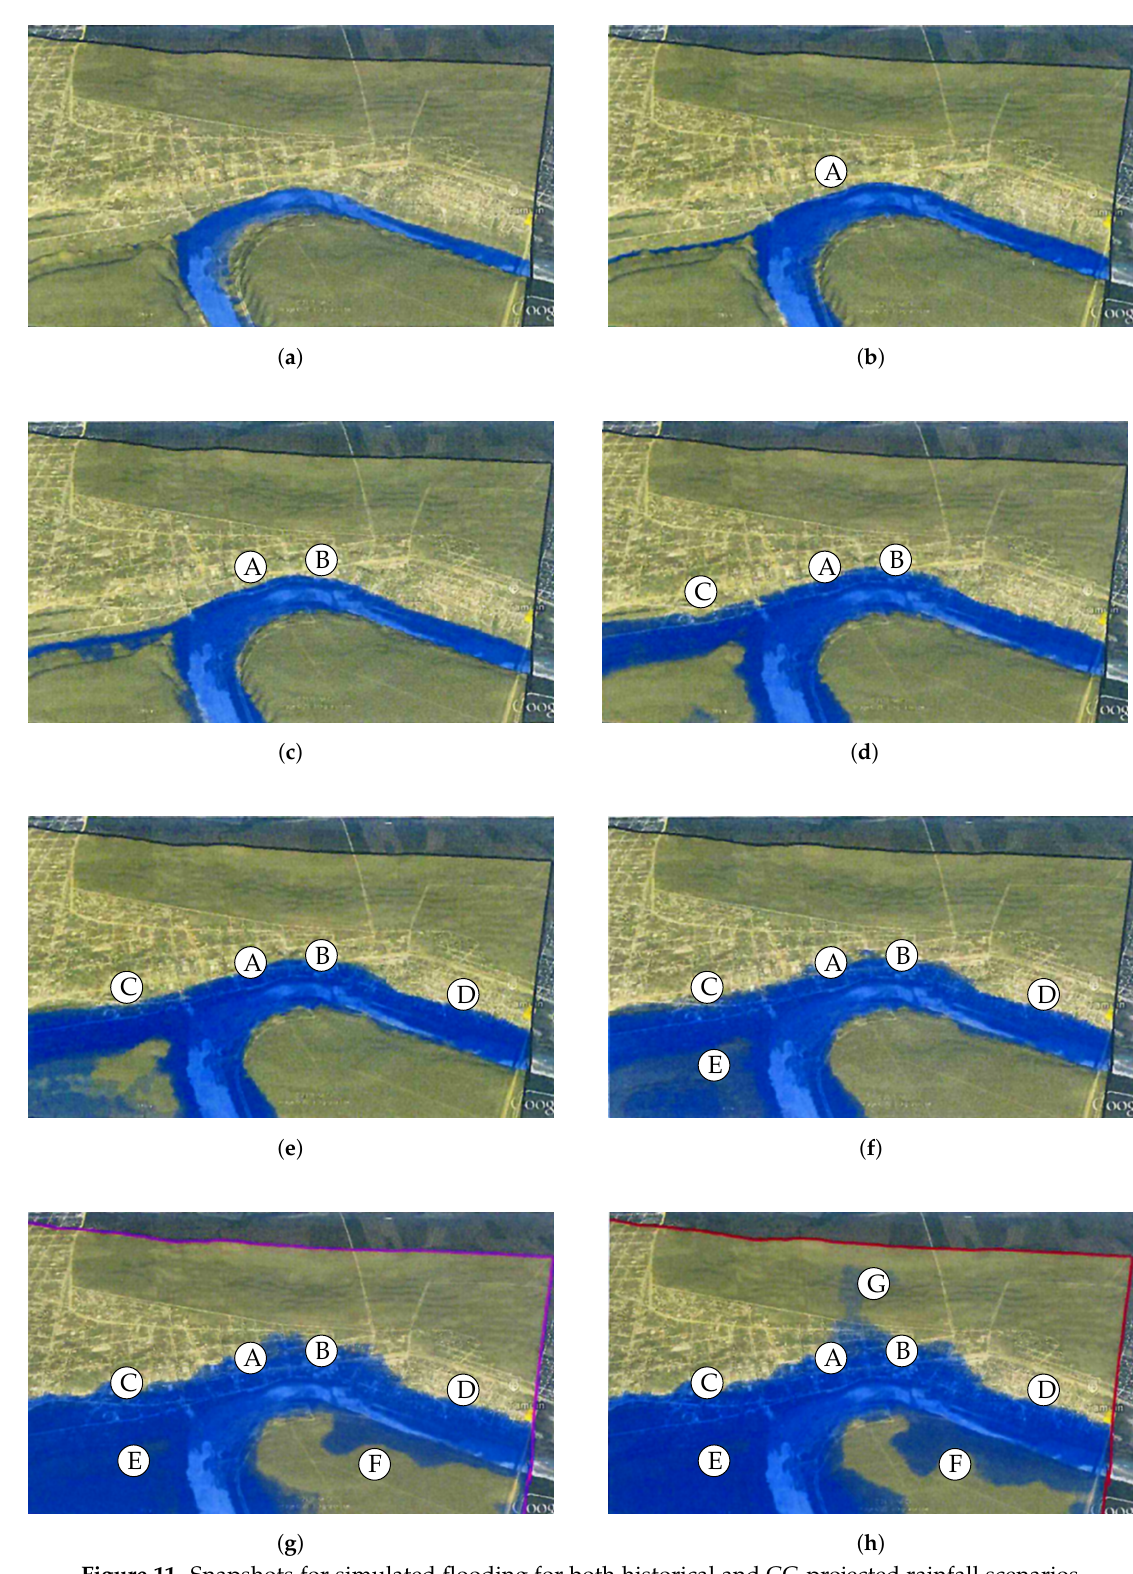
Figure 11. Snapshots for simulated flooding for both historical and CC-projected rainfall scenarios. (A)–(G) correspond to the first to seventh zones in risk of flood with respect to rainfall time. This zones are identified prioritising the urban zones. ( a ) corresponds to the initial condition before the simulation starts, while ( b – h ) are subsequent flooding stages during the simulations. ( h ) represents the worst flooding obtained within this